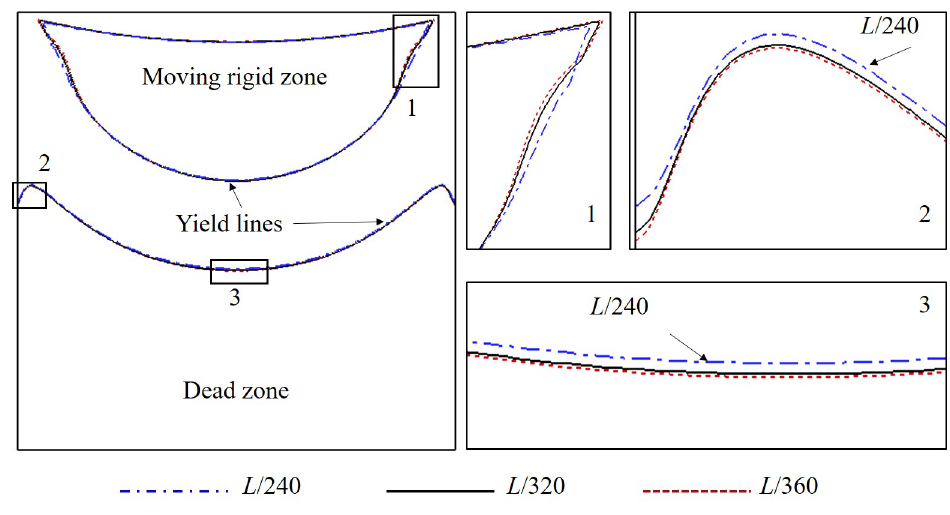
Figure 4. Influence of mesh refinement on the yield lines of ˙ γ = 0.001 s − 1 in a square cavity at Od = 10 .